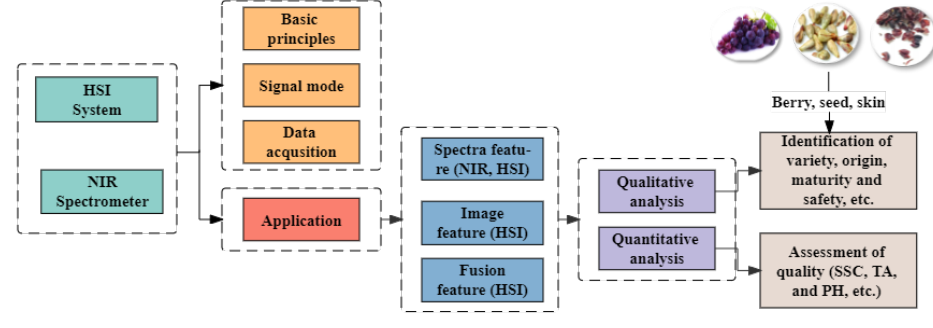
Figure 1. The mainframe of the